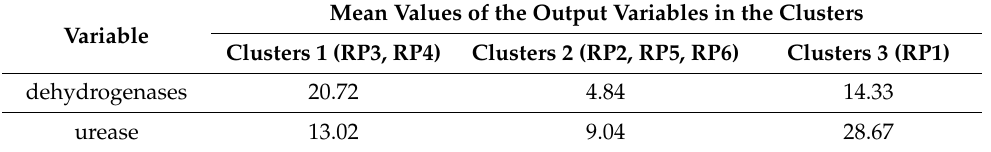
Table 10. Mean values of the output variables in individual clusters for dehydrogenases, phosphatase and urease.